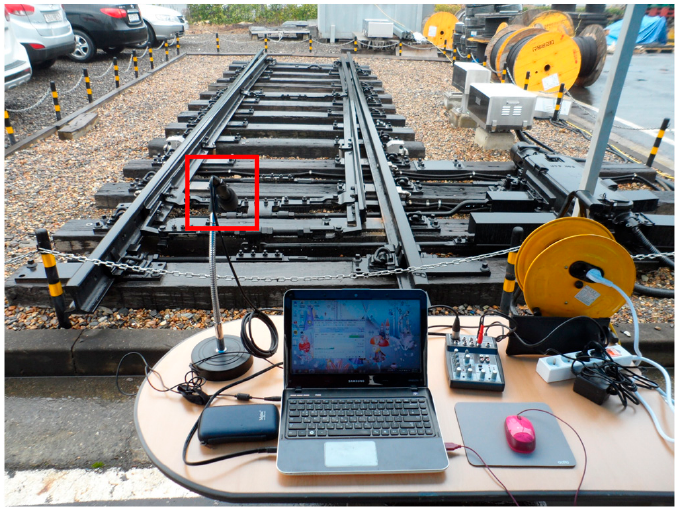
Figure 6. Data collection from NS-AM-type railway points.